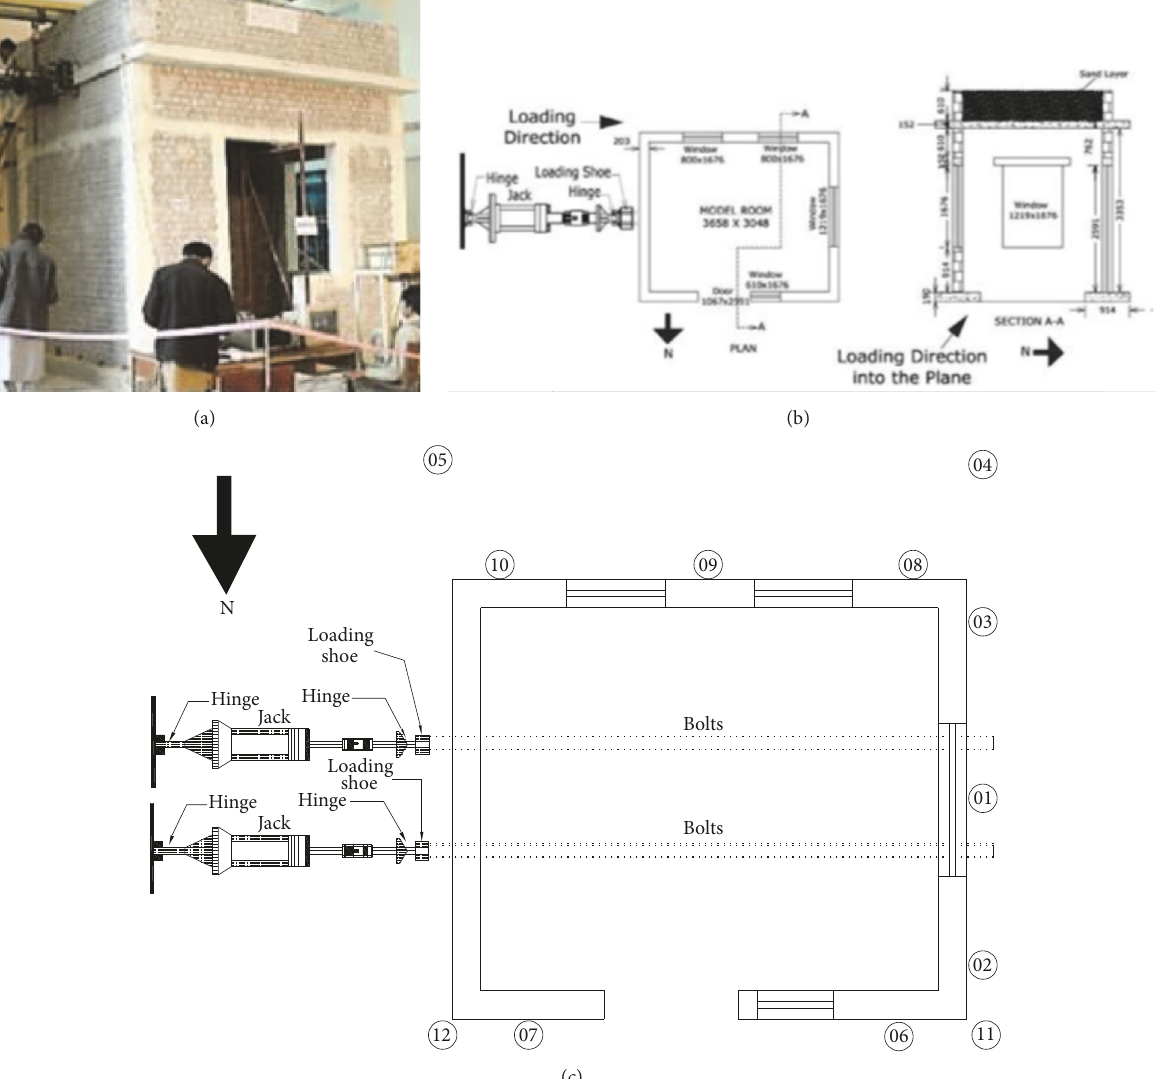
Figure 1: (a) A picture of the building model, (b) plan and elevation view details of full-scale building model, and (c) location of the hydraulic jacks in the tested